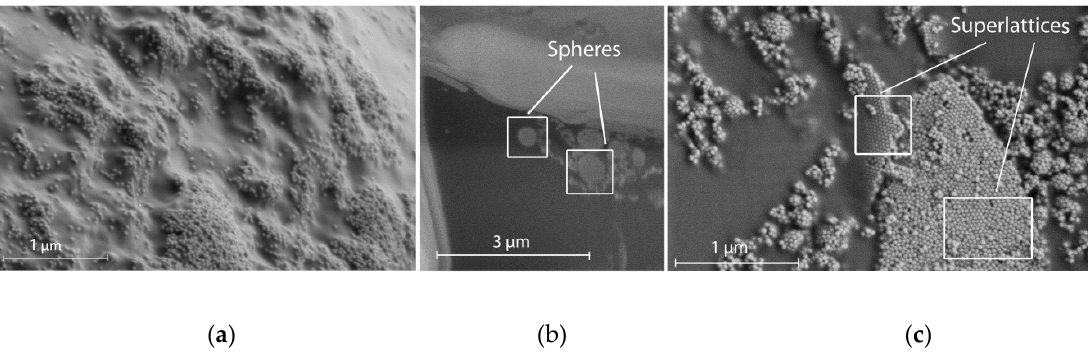
Figure 4. ( a ) SEM photograph of the polymer structure region with a disordered distribution of UCNPs. Two types of ordered nanoparticle structures formed in the nanocomposite in the course of photopolymerization: spheres ( b ) and superlattices ( c ).